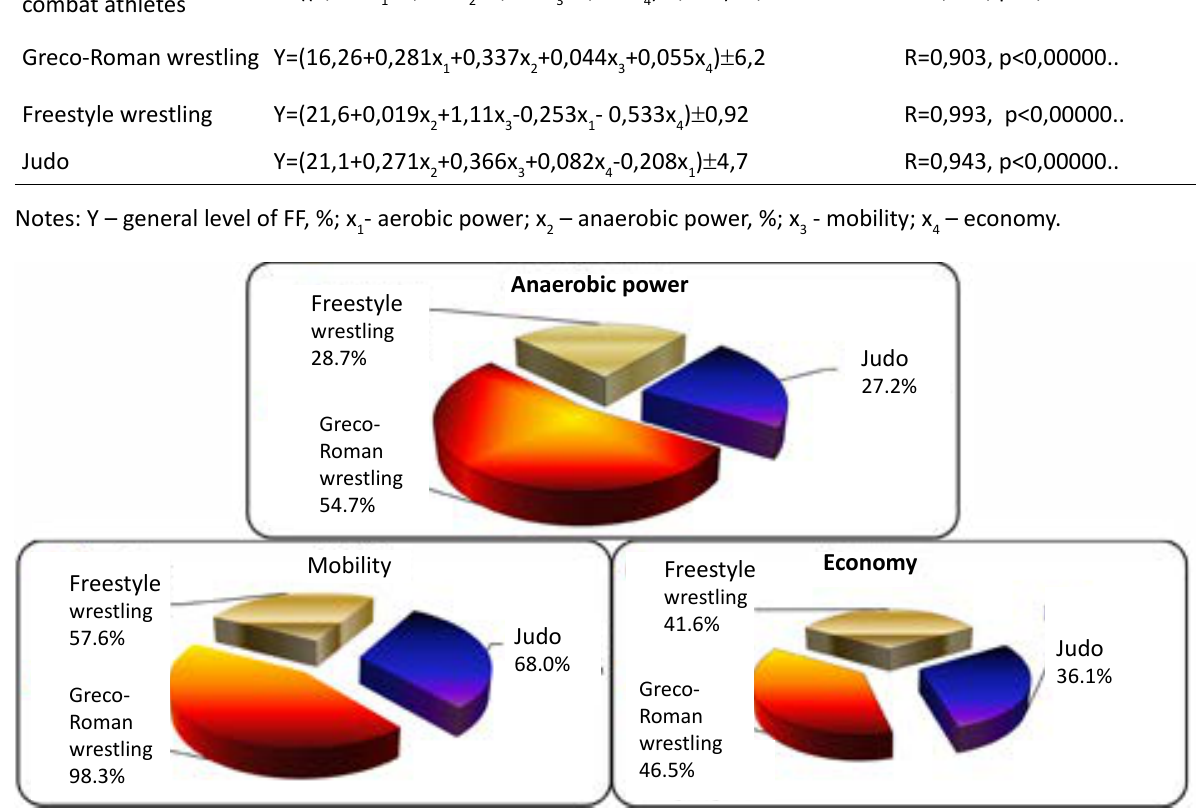
Fig. 1. Ratio of the components of functional fitness structure in athletes specialized in judo, freestyle and Greco- Roman